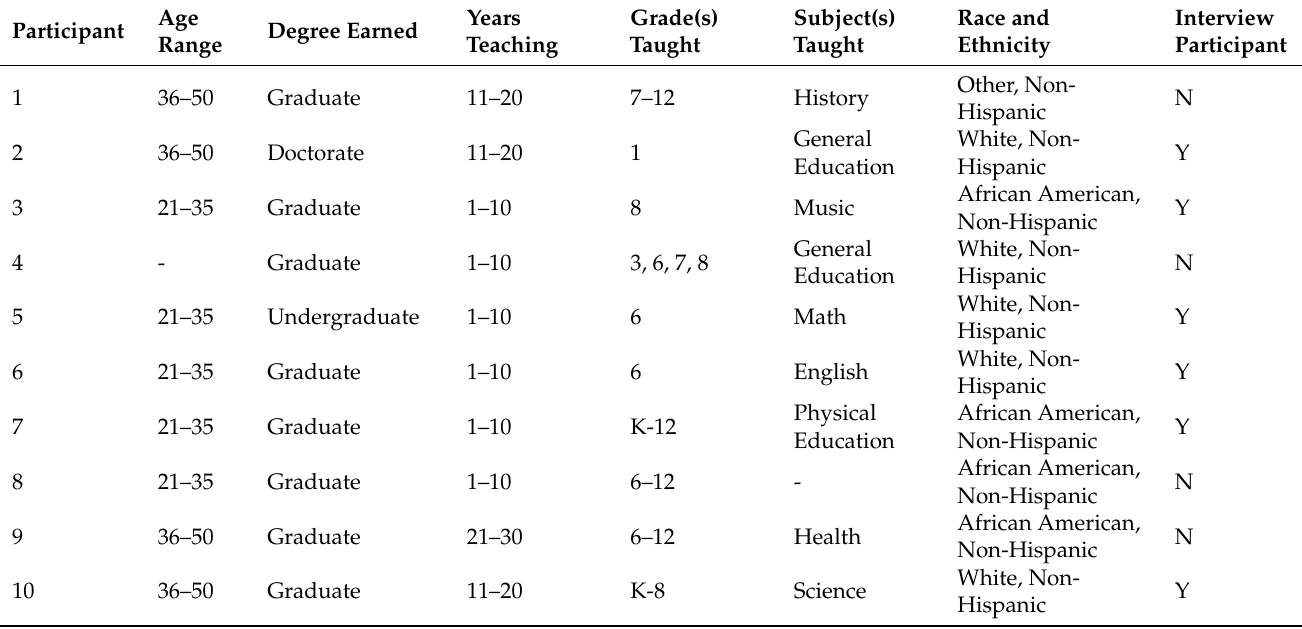
Table 1. Participant Background, Basic Demographic and Interview